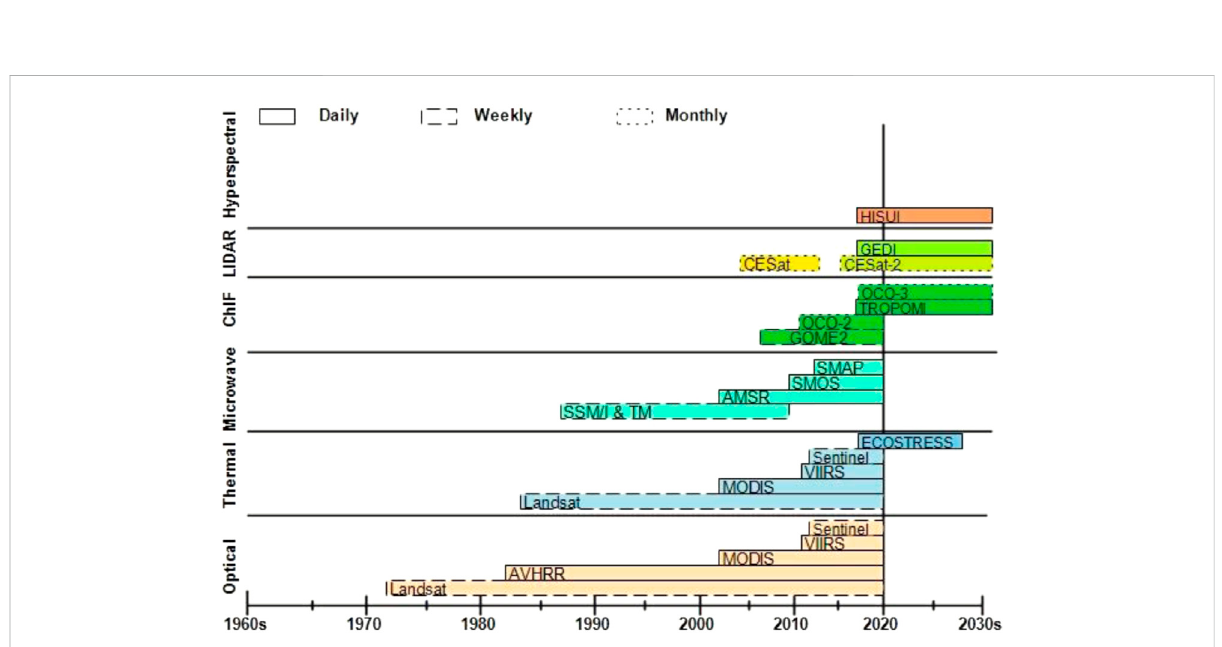
FIGURE 4 Advances in satellite imagery and multi-spectral RS of dryland vegetation dynamics. Historical milestones are provided from the 1960s to the 2030s. Timelinesof LiDAR, chlorophyll fl uorescence (ChIF),thermal infrared (TIR), microwave, optical,and hyperspectral earth observation satellites are shown. The progression of satellite capabilities from optical to hyperspectral indicates both the rising spatial and temporal resolution of sensor informationaswellastheextensionofRStechniquesindrylands. Modi fi edandadaptedfrom(Kuenzeretal.,2014;Smithetal.,2019).Thecolor differentiates the type of satellite and its capability. The solid, semi-solid, and dash-dash lines represent daily, weekly, and monthly scales, respectively, as the data acquisition